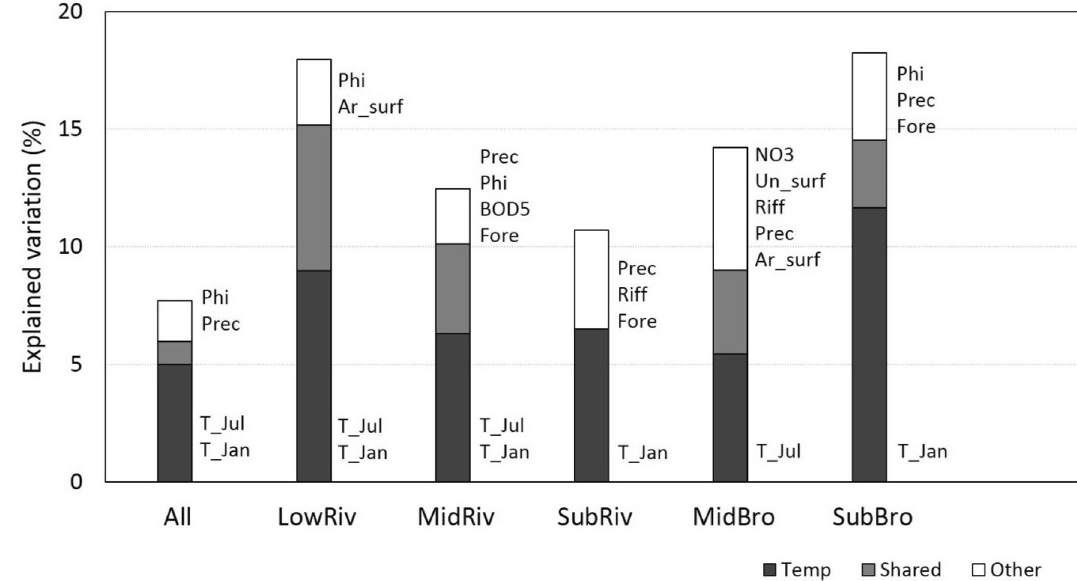
Figure 4. Total, pure and shared variation explained by temperature and other environmental variables in macroinvertebrate assemblages of the 65 stream sites compared between 1997–2000 (period 1) and 2015 (period 3). Counted as R 2 adj. by Distance-Based Redundancy Analysis (db-RDA) using Bray–Curtis dissimilarities of ln(x + 1) transformed abundance data, for the total dataset and separately for five stream types: low altitude rivers (LowRiv), mid-altitude rivers (MidRiv), submontane rivers (SubRiv), mid-altitude brooks (MidBro), and submontane brooks (SubBro). Significant environmental variables: mean air temperatures in January and July (T_Jan, T_Jul), annual precipitation (Prec), roughness of bed substrate (Phi), concentration of nitrates (NO 3 ), artificial surfaces (Ar_surf), unfavourable surfaces (Un_surf), share of riffles (Riff), forested area (Fore), biochemical oxygen demand (BOD5). The models were significant at p < 0.01, permutations were restricted to sites. Temp—pure effects of temperature variables; Shared—effects shared by temperature and other environmental variables; Other—pure effects of other environmental